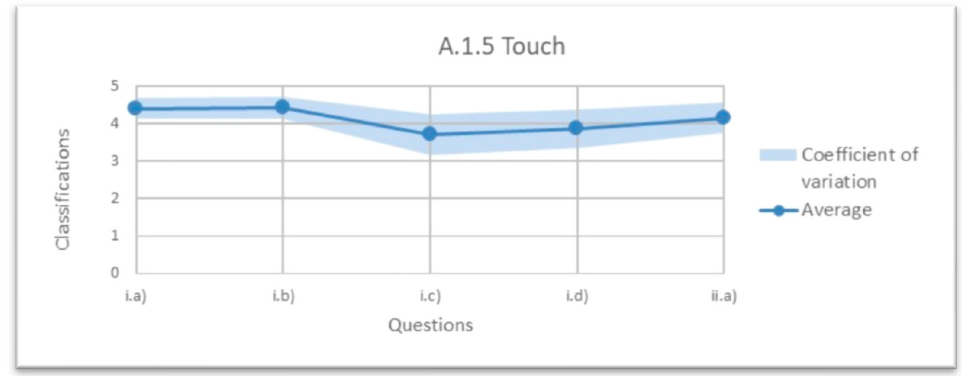
Figure 7. Average ratings of comfort touch.